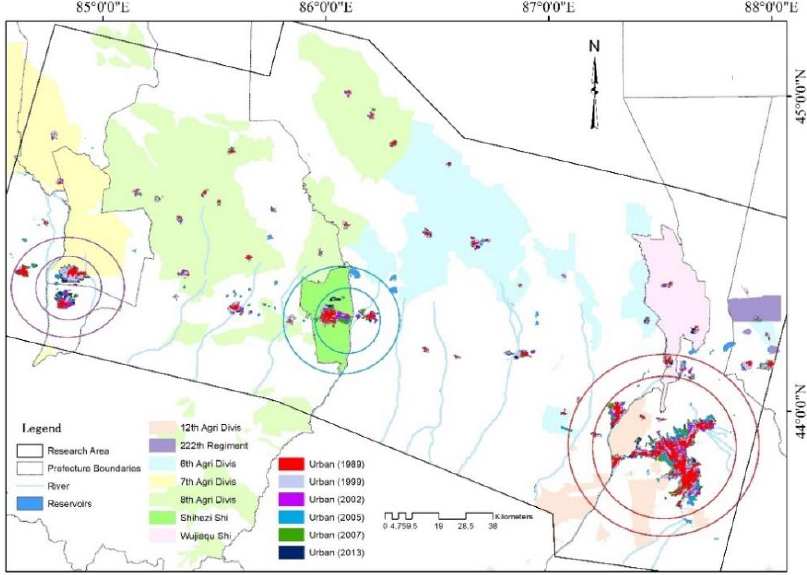
Figure 4. Changes in the built-up areas and the aggregation pattern in the NXEZ from 1989–2013.